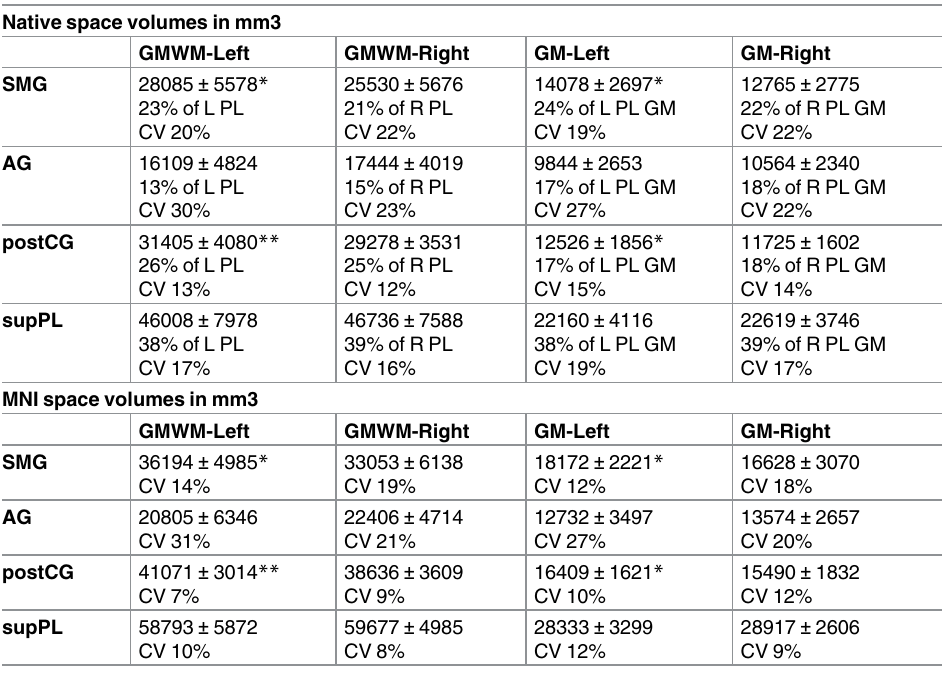
Table 4. Volumes of parietal